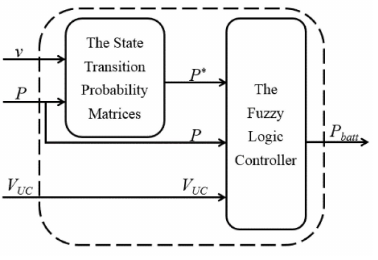
Figure 14. The structure of the proposed power distribution strategy for